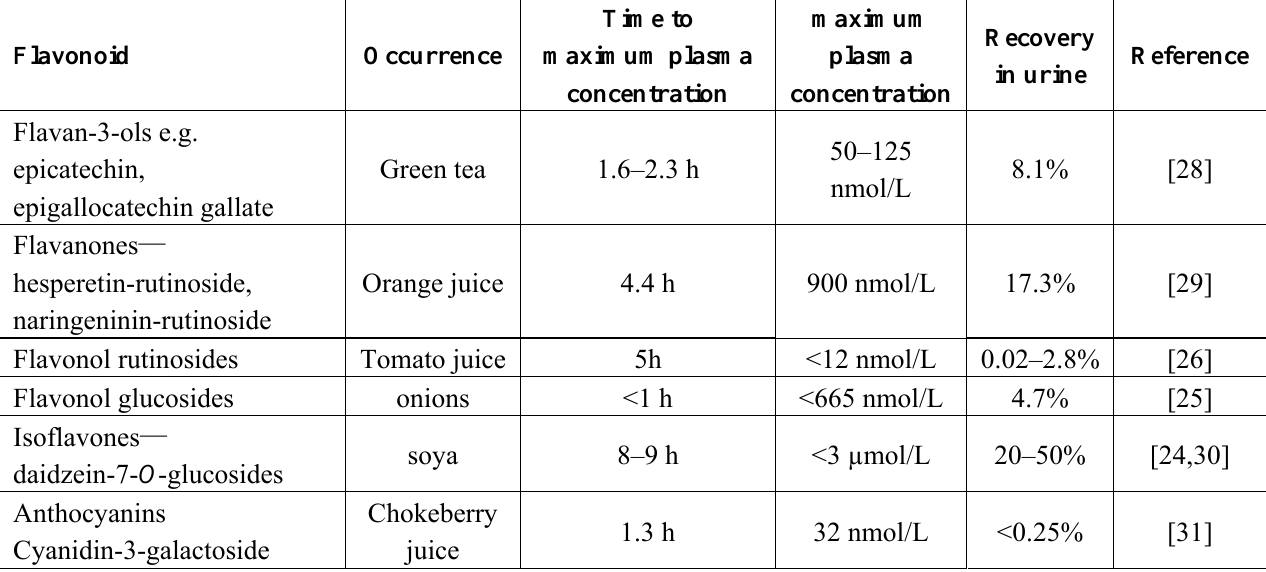
Table 1. Bioavailability of selected